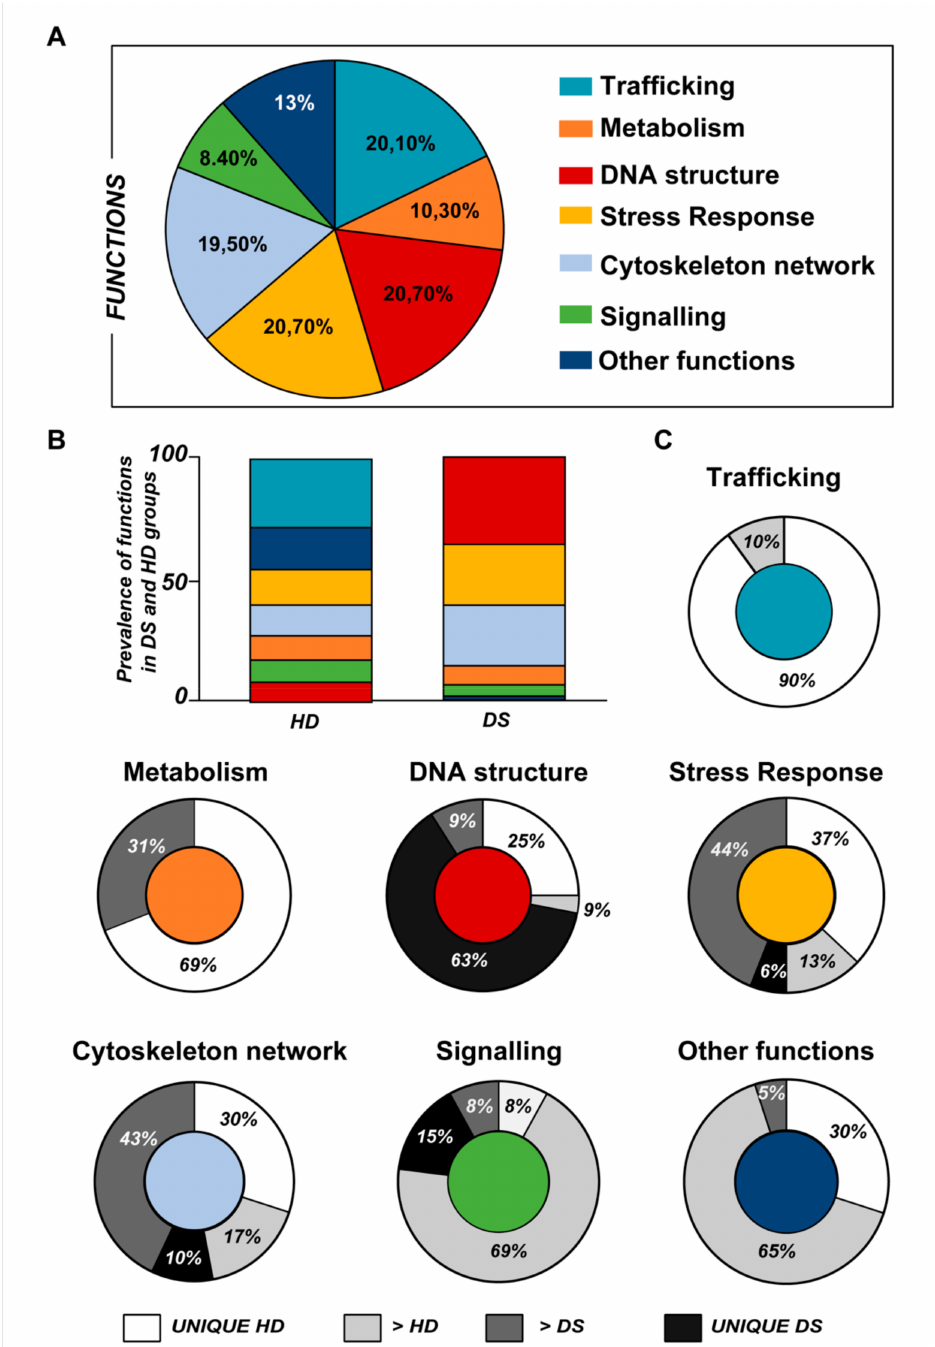
Figure 3. ( A ) Pie chart representing all the proteins grouped according to their function. ( B ) Representative graph showing the prevalence distribution of the listed functions in the HD and DS groups, respectively. ( C ) Pie chart representing all the functions reported in the work and the related alterations among the groups of analysis (UNIQUE HD, UNIQUE DS, > HD, and >